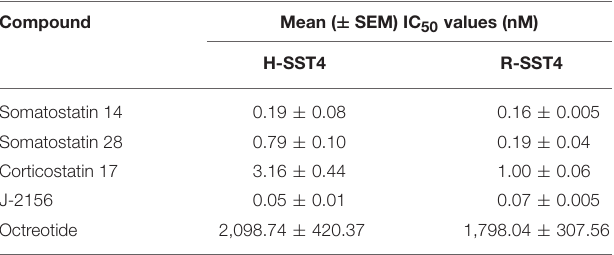
TABLE 2 | Potency of somatostatin agonists for human and rat SST4 receptors determined by forskolin-stimulated cAMP functional assays.